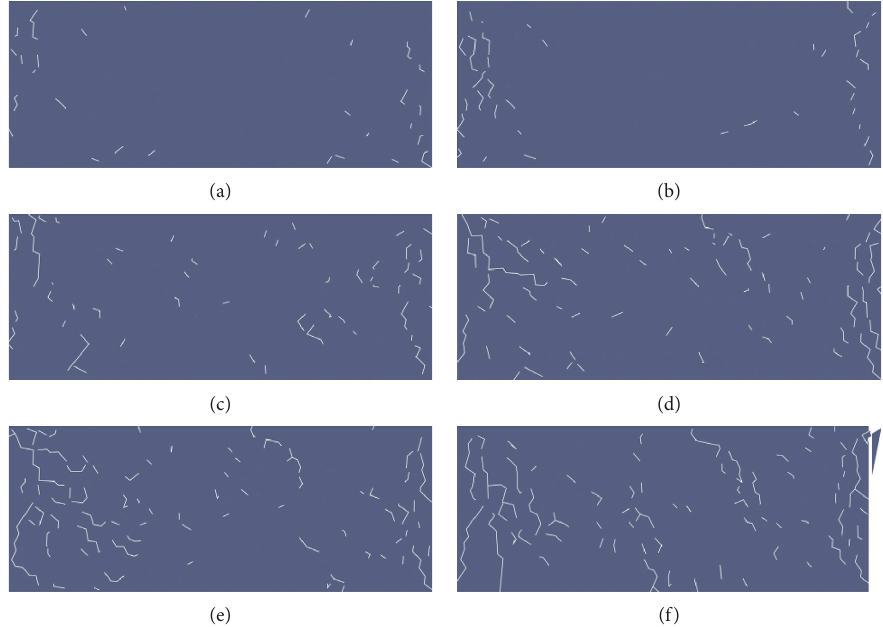
Figure 8: Crack evolution in Pillar B versus model time steps. (a) After excavation of three rooms in #4 seam. Panel in #6 seam advancing by (b) 50 m, (c) 80m, (d) 90m, (e) 100m, and (f)